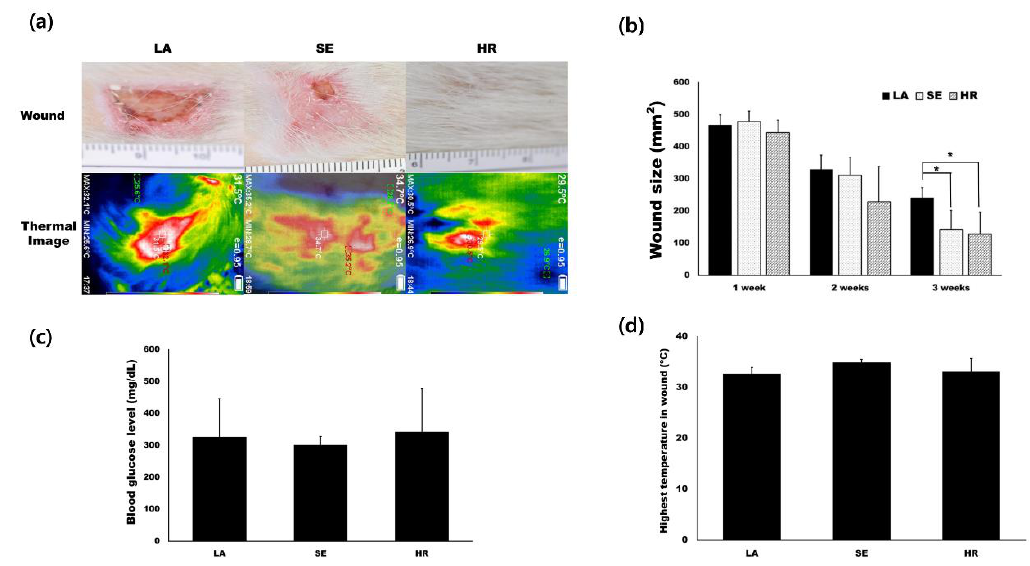
Figure 3. Animal experiments. ( a ) Images for residual wound and thermogram at 3 weeks after injury. The images at different time points are available in Figure S5. ( b ) Residual wound size was significantly different at 3 weeks after injury. Compared to the ointment base only group, the 4HR and sericin groups showed a significantly small size of the residual wound ( p = 0.022 and 0.049, respectively). ( c ) The average blood glucose level was approximately 300 mg/dL in all groups and there was no significant difference among groups ( p > 0.05). ( d ) In the case of surface temperature, the sericin group was the highest and the 4HR group was followed (LA; lanolin only, SE; sericin, HR; 4HR).